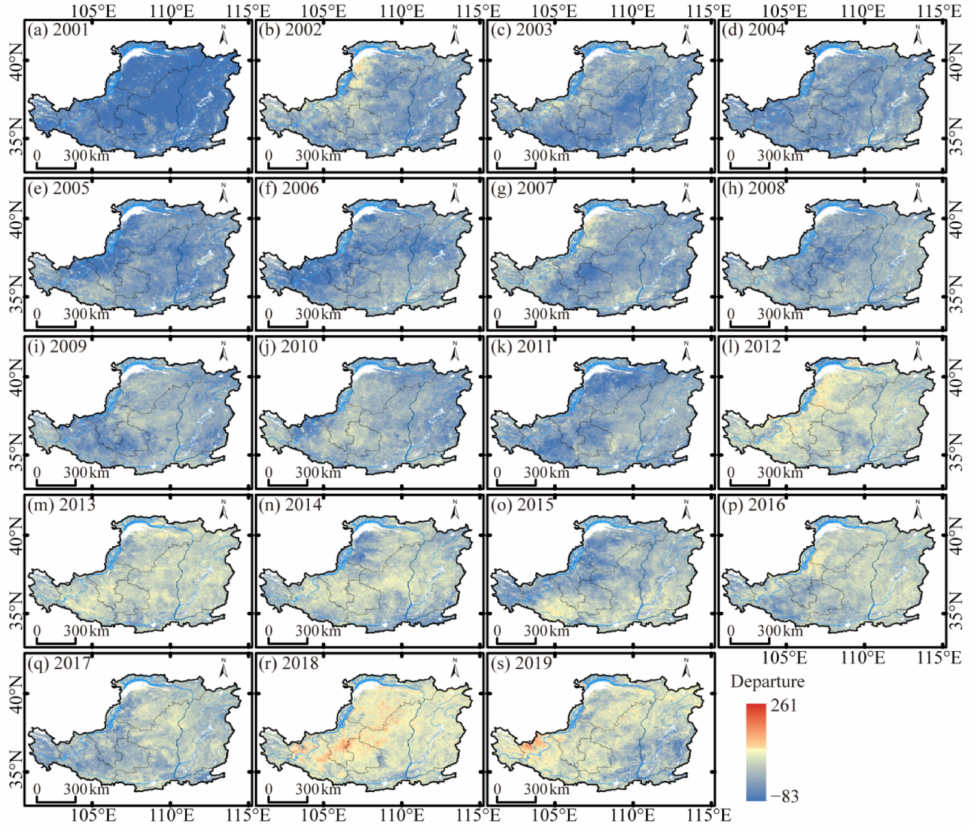
Figure 6. Spatial pattern of the departure percentage of WVCI across the Loess Plateau from 2001 to 2019.